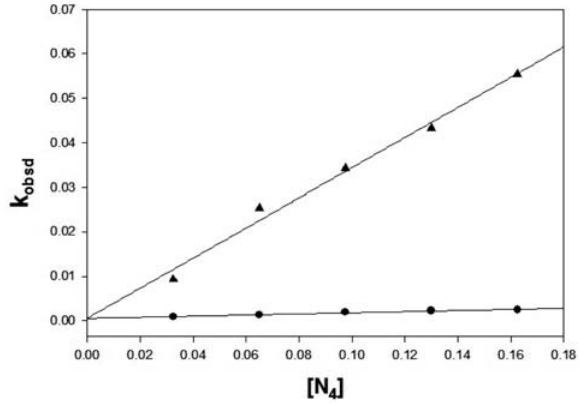
Fig.4. Plot of the rate constants k bctn for Cu(bctn)(NO